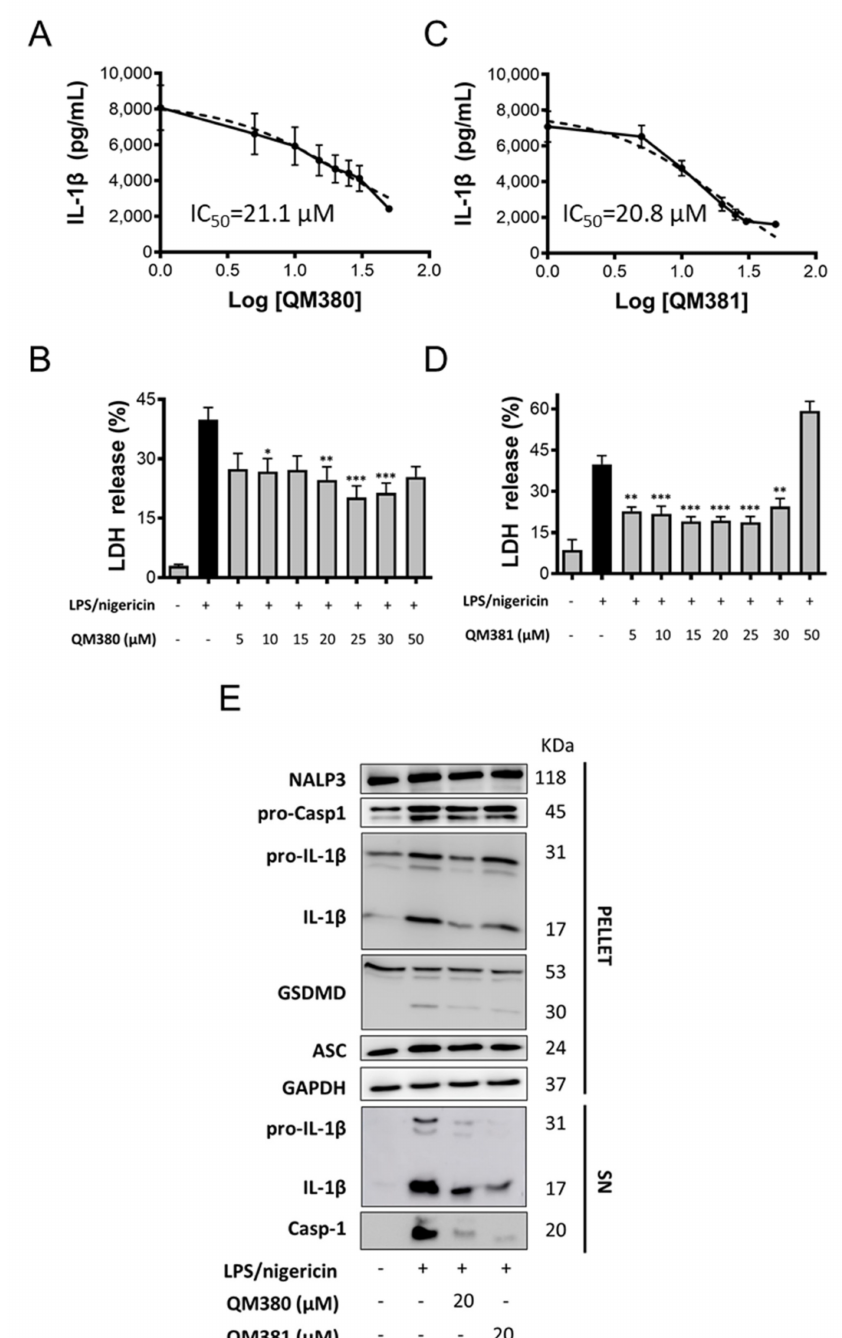
Figure 5. QM380 and QM381 inhibit NLRP3 activation mediated by LPS and nigericin stimulation in PMA-differentiated THP-1 cells. The ELISA technique evaluated IL-1 β secretion upon activation of the NLRP3 inflammasome with LPS (100 ng/mL) and nigericin (20 µ M) and treated or not with QM380 ( A ) or QM381 ( B ) at different concentrations. Measurement of LDH release under the above- described conditions for QM380 ( C ) and QM381 ( D ) treated cells. ( E ) THP-1 cells were stimulated as described above, and supernatants (SN) and pellets were analyzed by immunoblotting for IL-1 β and cleaved caspase-1. A representative Western blot is shown. Asterisks represent significant differences compared to the stimulated control (LPS/nigericin) as determined by a one-way ANOVA test with Tukey’s multiple post-test comparisons * p < 0.05; ** p < 0.01; *** p < 0.001. All data are expressed as the mean ± SD of three